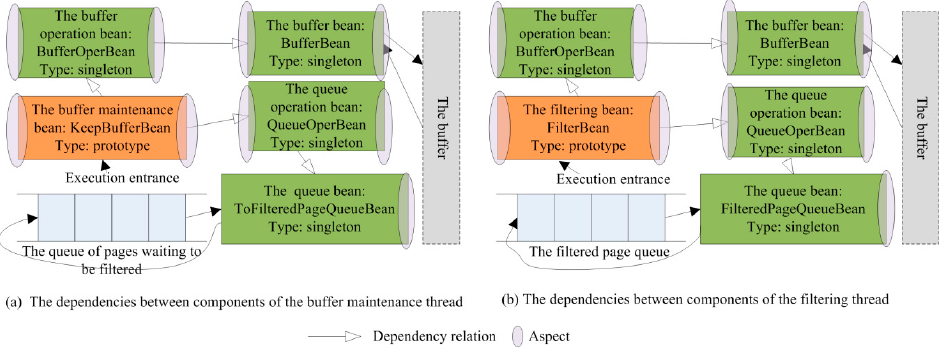
Figure 3. The Spring’s AOP idea and Spring’s IoC idea in the two threads.